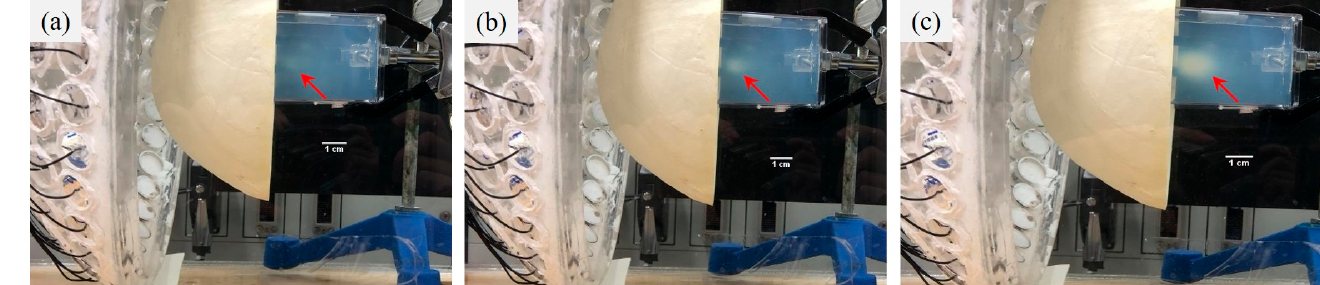
Figure 10. Ultrasonic hyperthermia in the phantom by switching the focusing pattern 1 and focusing pattern 2. The write lesion increased with the sonication time. ( a – c ) show the pictures of the phantom exposed to ultrasound at 1 min, 2 min and 3 min, respectively. The lesions were pointed out by red arrows.